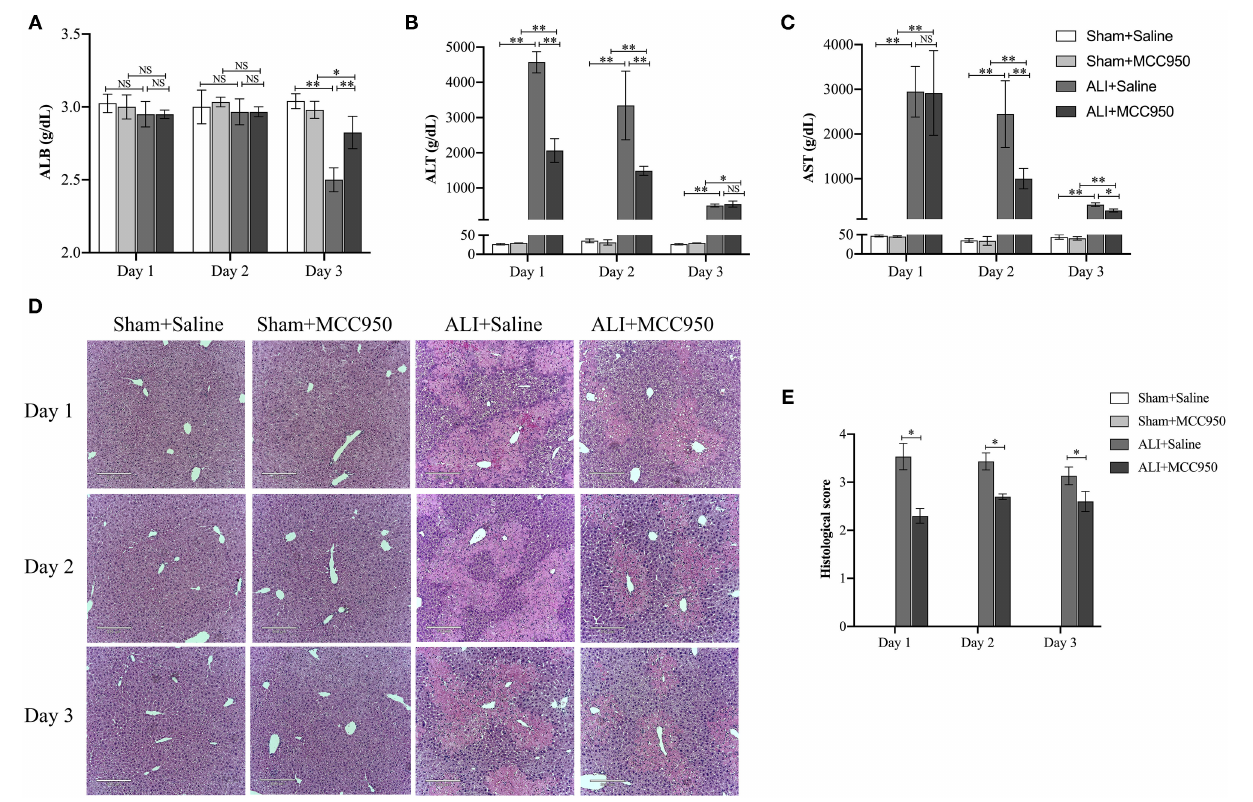
FIGURE 1 | MCC950 alleviates acute liver injury. (A) Time course of ALB serum levels in different mice ( n = 8). (B) Time course of ALT serum levels in different mice ( n = 8). (C) Time course of AST serum levels in different mice ( n = 8). (D) Histological examination of mouse paraffin liver sections stained with H&E staining from carbon tetrachloride (CCl 4 )-treated mice pretreated with vehicle or MCC950. (E) The histological scores for liver sections in different groups. Data are presented as mean ± SEM. NS: No significance. * p < 0.05, ** p < 0.01. Intergroup differences are determined by the Student’s t -test.